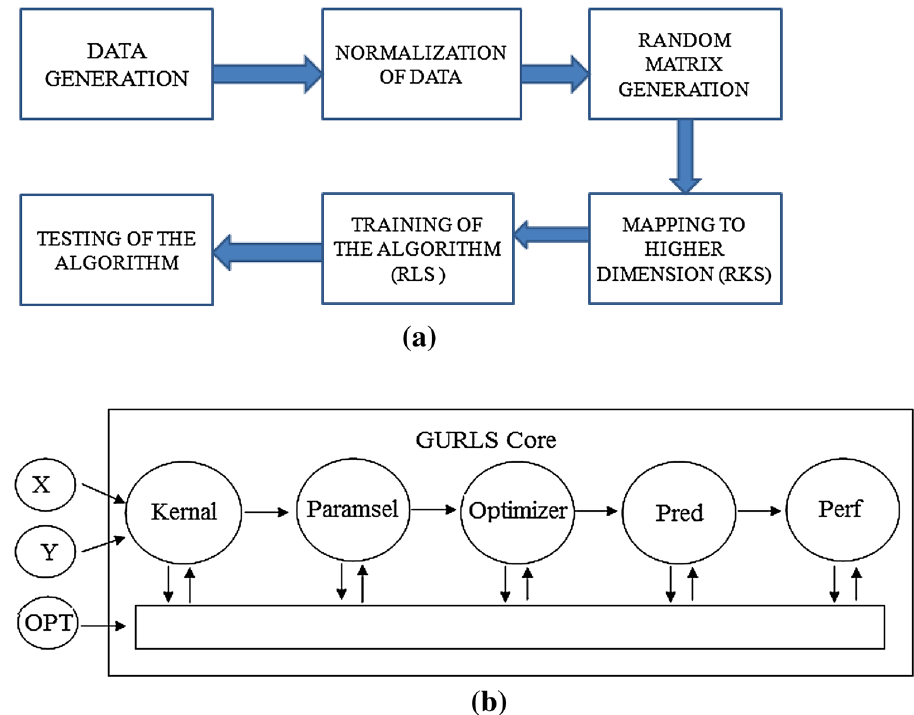
Fig. 1 a Flow chart of the work flow and b Work flow in GURLS